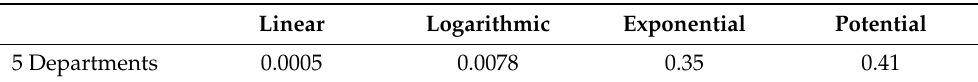
Table 4. R 2 value correlates GDP and tertiary roadway network length between villages and districts with its municipal capital.